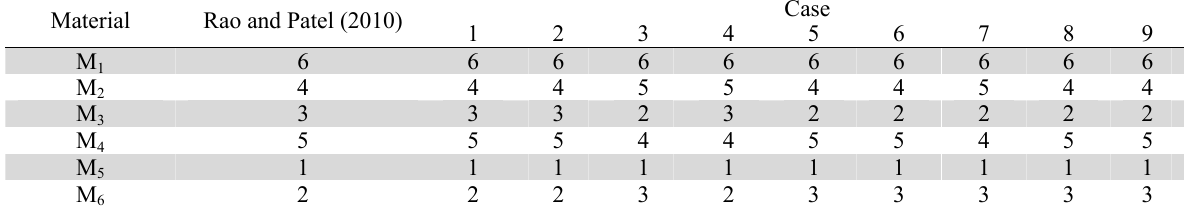
Rankings of high speed naval craft materials using VIKOR method Material Rao and Patel (2010)